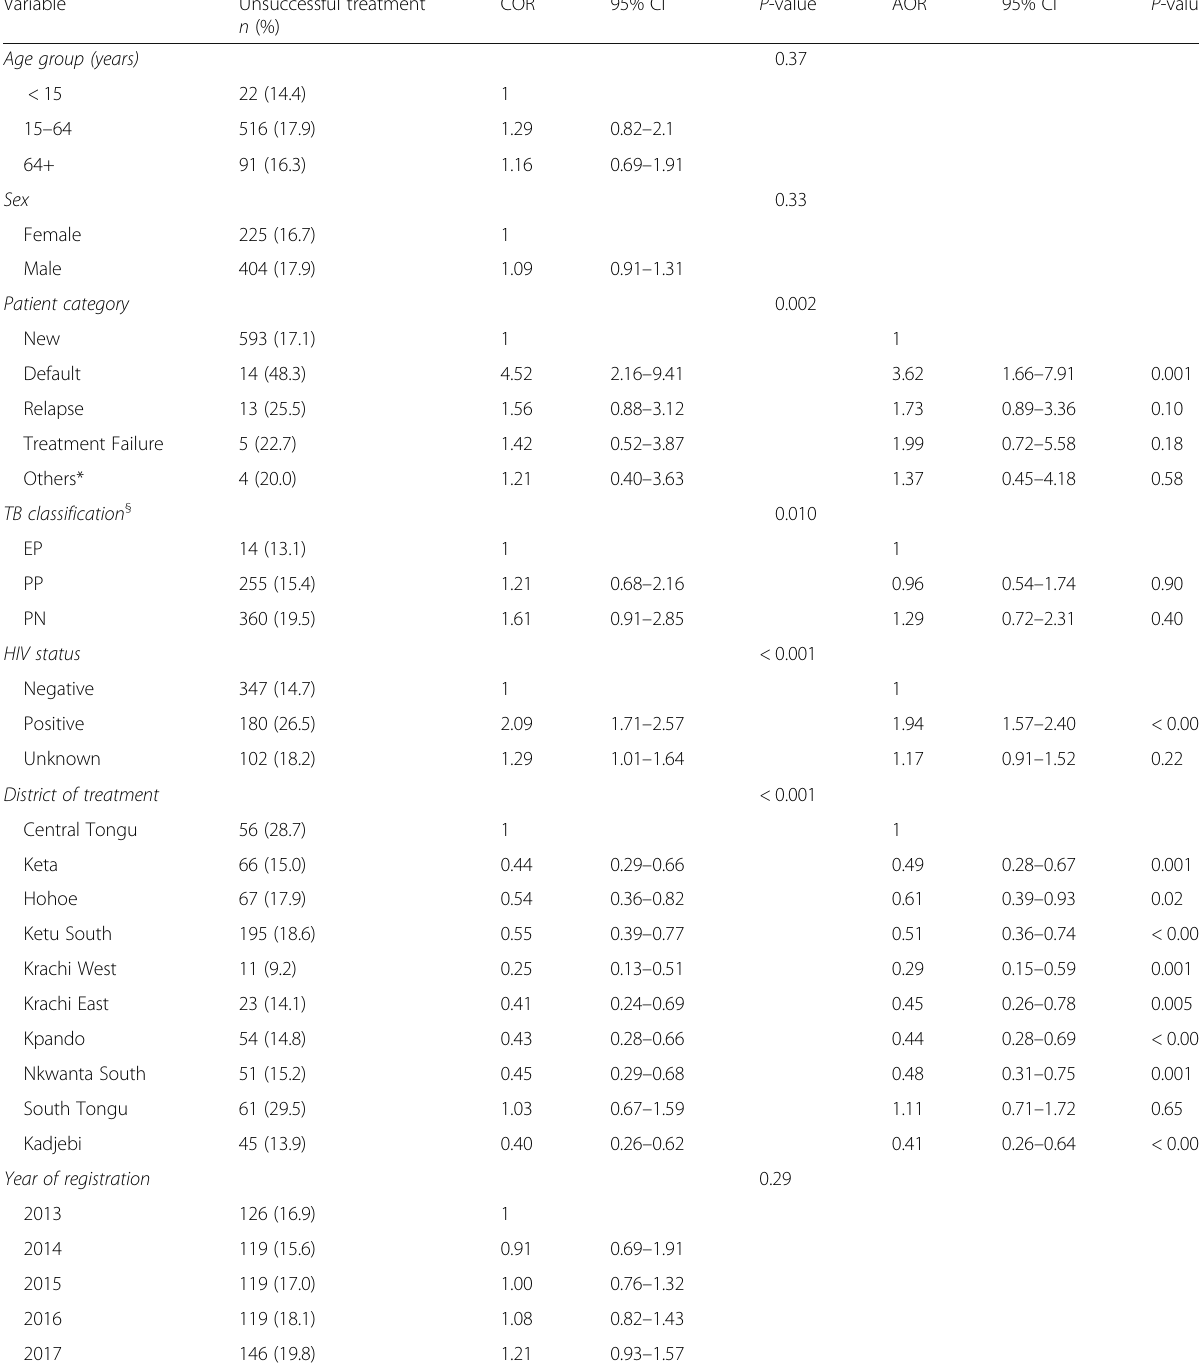
Table 3 Logistic regression of patient and disease characteristics as predictors of unsuccessful treatment outcomes